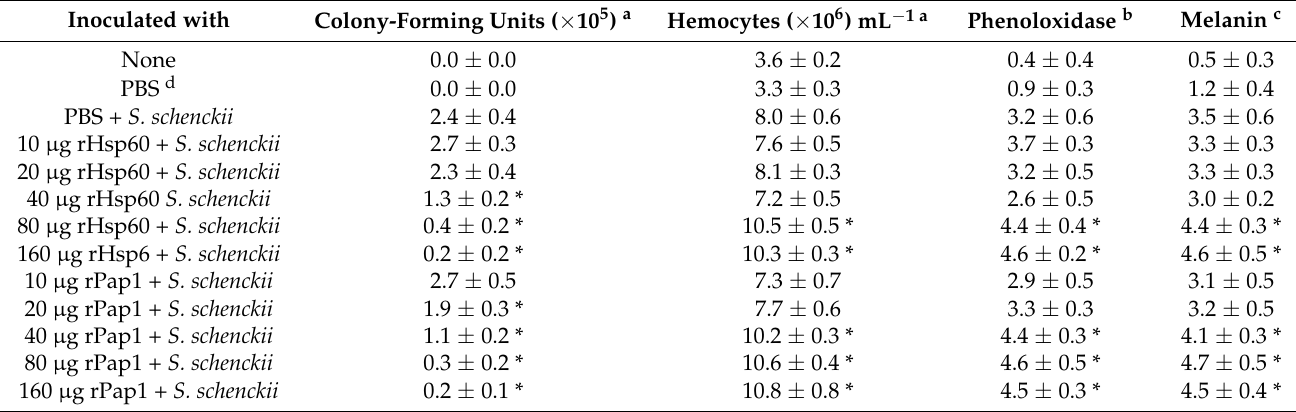
Table 3. Colony-forming units, hemocyte counts, phenoloxidase, and melanin production in Galleria mellonella larvae pre-inoculated with either recombinant Hsp60 or Pap1 and challenged with Sporothrix schenckii yeast-like cells. Inoculated